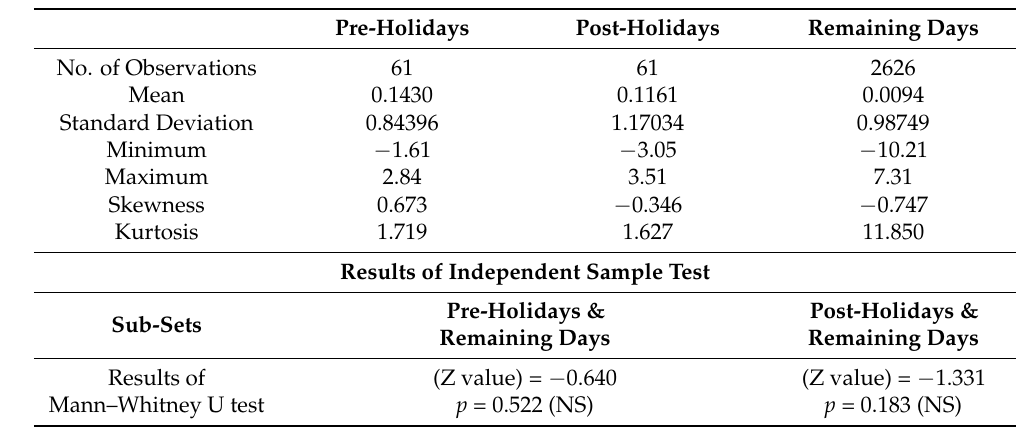
Table 8. The Results of Descriptive Statistics for DSM 20 Index Daily Returns for Pre,